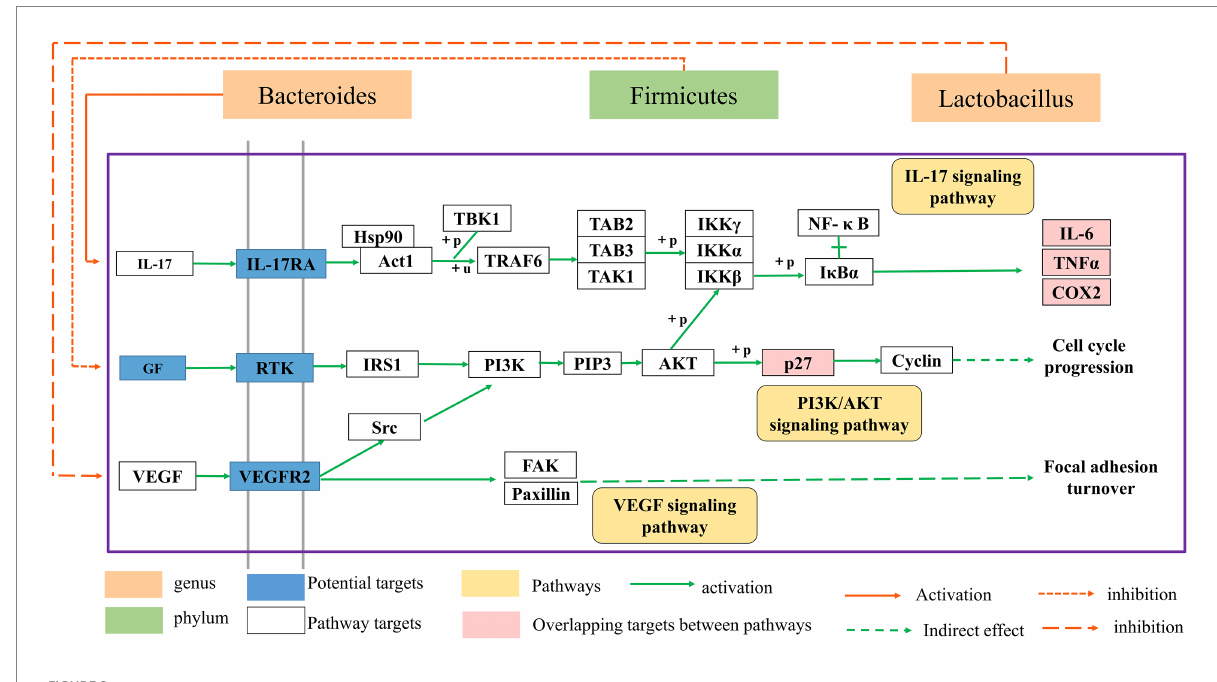
FIGURE 8 The relationship between the gut microbial ecosystem and the PI3K/AkT, IL-17, and VEGF signaling